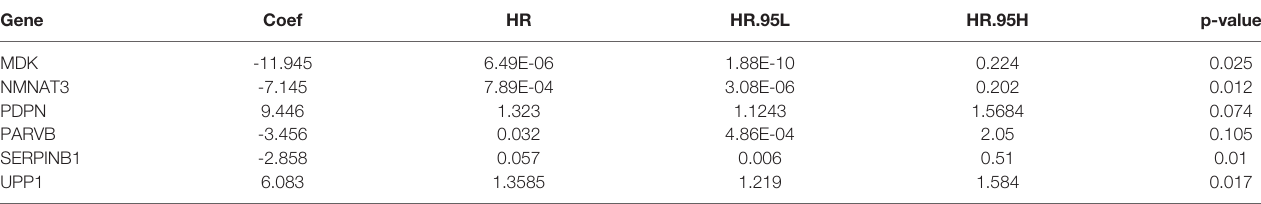
TABLE 1 | Coef fi cients based on a multivariate Cox regression analysis of the selected genes. Gene Coef HR